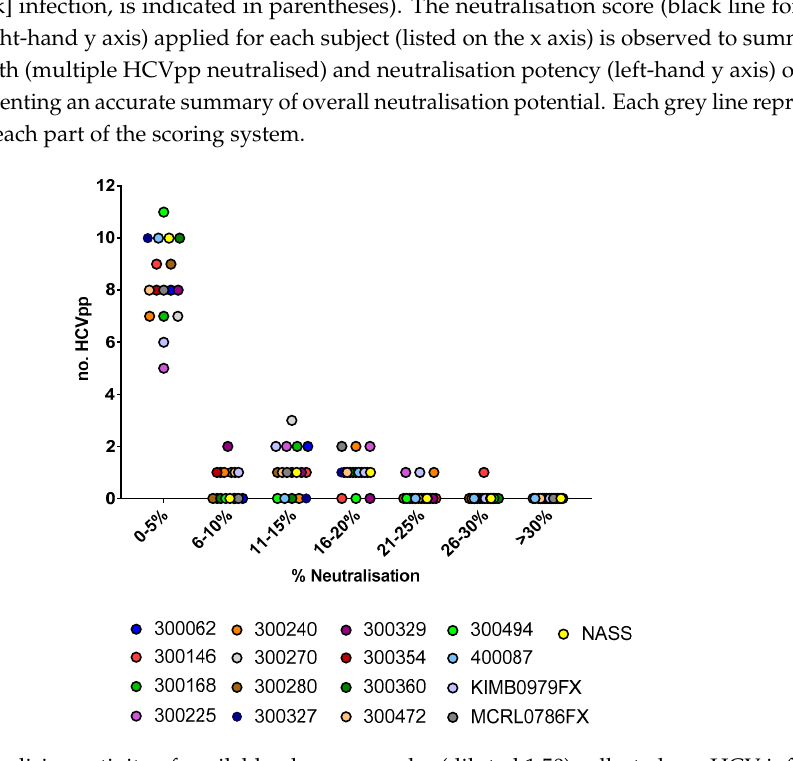
Figure 3. Neutralising activity of available plasma samples (diluted 1:50) collected pre-HCV infection ( n = 17) compared to a healthy control. All 17 subjects were tested against a panel of 11 HCVpp, representing GT1 to 6. While all subjects demonstrated some neutralising activity, this was below the 20% cut off (grey line) with the exception of single HCVpp for subjects 300146 (UKN3A1.9, 27.9% neutralisation), 300225 (UKN1A20.8, 21.0% neutralisation), KIMB0979FX (UKN3A13.6, 21.7% neutralisation), and NASS0384MX (UKN3A1.9, 20.5% neutralisation). Given that 97.9% of